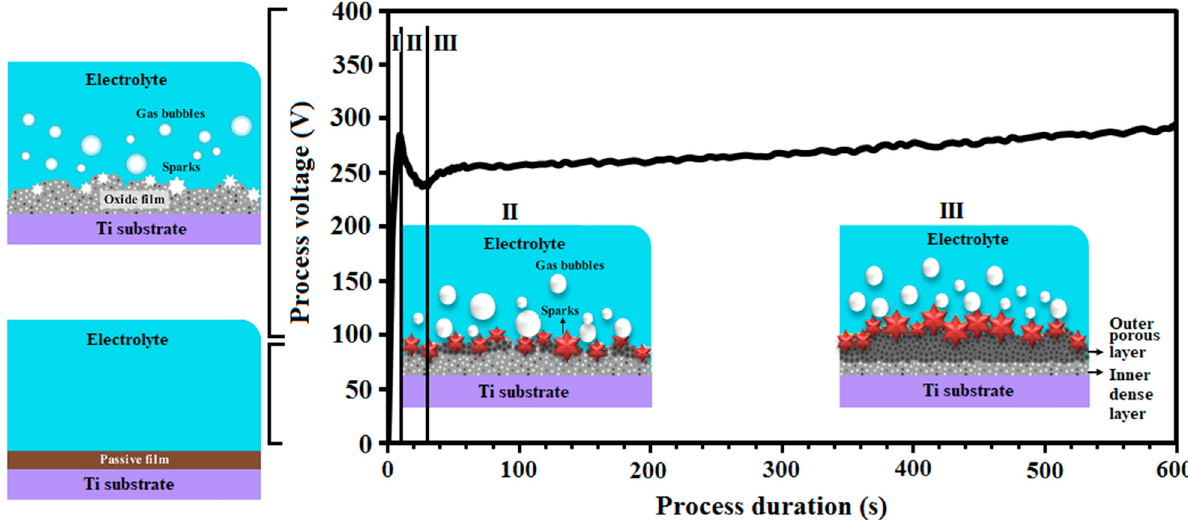
Figure 1. The V-t chart for the PEO process.